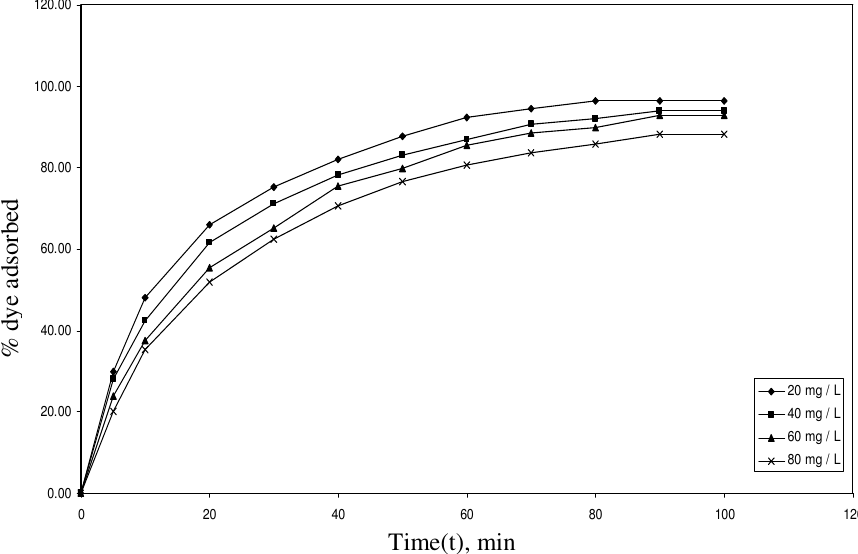
Figure 2 . Effect of agitation time on adsorption –initial concentration